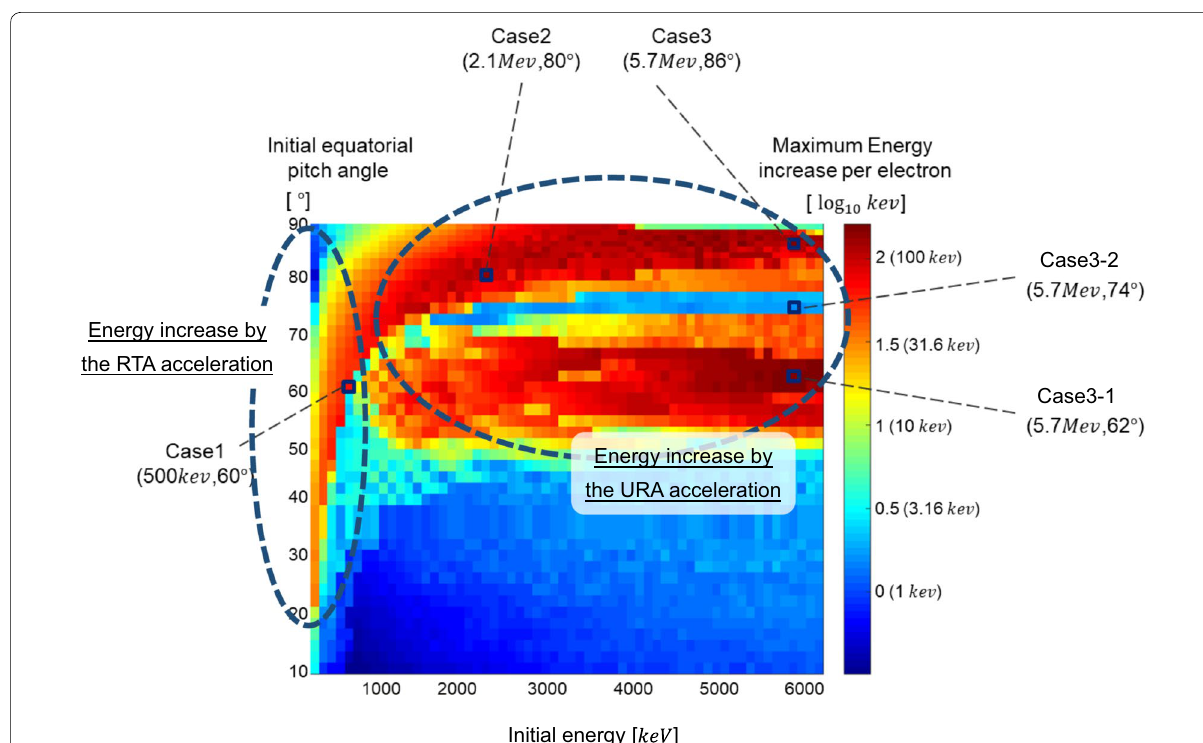
Fig. 4 Energy increase profile of the most successfully accelerated electron under each initial condition. Comprehensive simulations are conducted under various initial conditions: 60 energy levels and 43 equatorial pitch angles. Each condition is applied for 3600 electrons with different gyrophases and initial positions. The energy increase of the most successfully accelerated electron out of the 3600 electrons in each case is visualized in the colormap. The high energy increase range (colored in red) with lower initial energy electrons results from the RTA acceleration, whereas the range over MeV-class initial energy is due to the URA acceleration. The URA high energy range consists of two bands separated by a cavity at the initial pitch angle of around 70°. The upper band and lower band are formed by the different types of URA: overtaken URA and catching up URA, respectively. The cavity is the intermediate condition, where no efficient acceleration